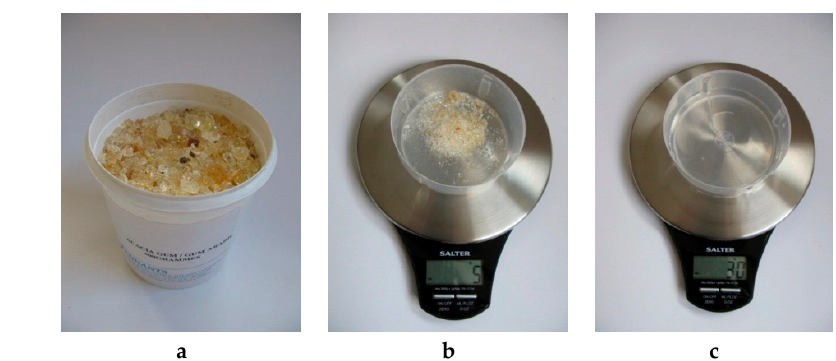
Figure 8. Measuring the Acasia gum/Gum Arabic and water.